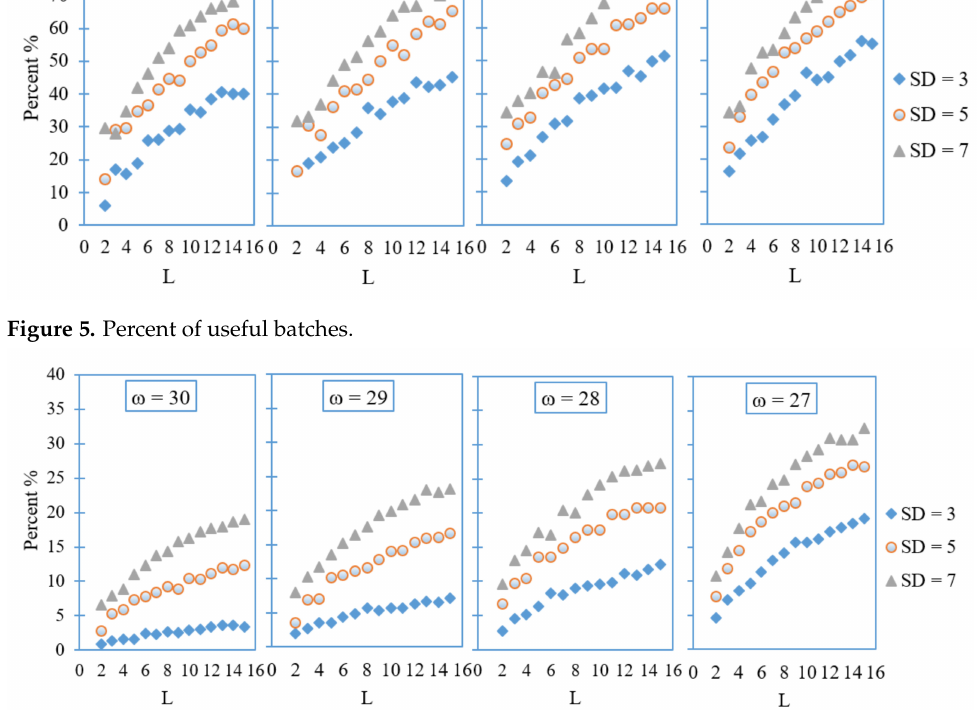
Figure 6. Percent of reduced